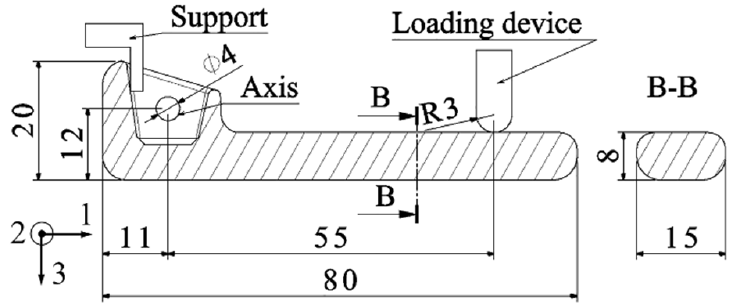
Figure 2. The outline of flexural test and the main dimensions of door handle. For the injection moulding simulation, the entire mould cavity with the sprue and the runner system was modelled. The model was built using three-dimensional tetrahedron elements (192,045 tetrahedron elements, 190,710 nodes), taking the location of the subse- quent mortise into consideration (Figure 3a). As for the simulation of injection moulding, Autodesk Moldflow Insight 2011 software (San Francisco, CA, USA) was used for the real raw material with the parameters used in injection moulding.